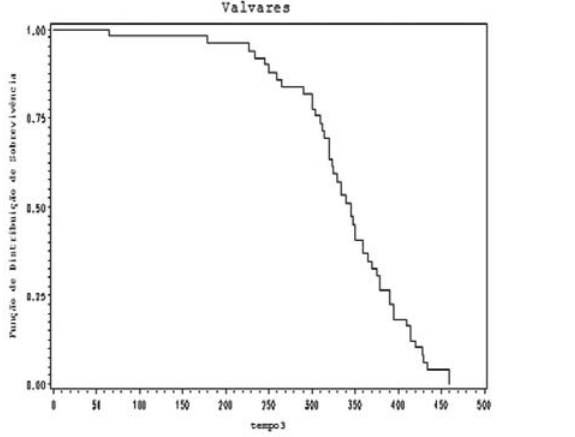
Fig. 8 - Sobrevivência por Tipo: Outros Procedimentos - tempo 3: T3 - Tempo da Presença do Doente na Sala de Operação